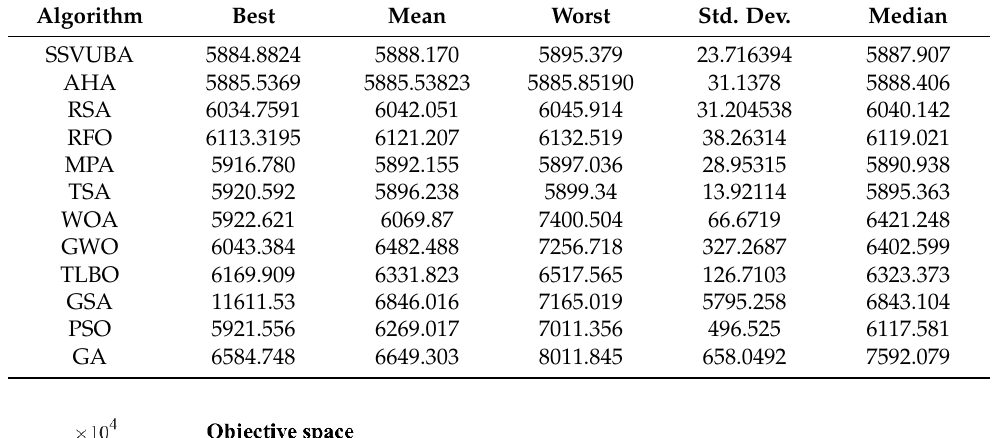
Table 11. Statistical results of optimization algorithms for the pressure vessel design problem.